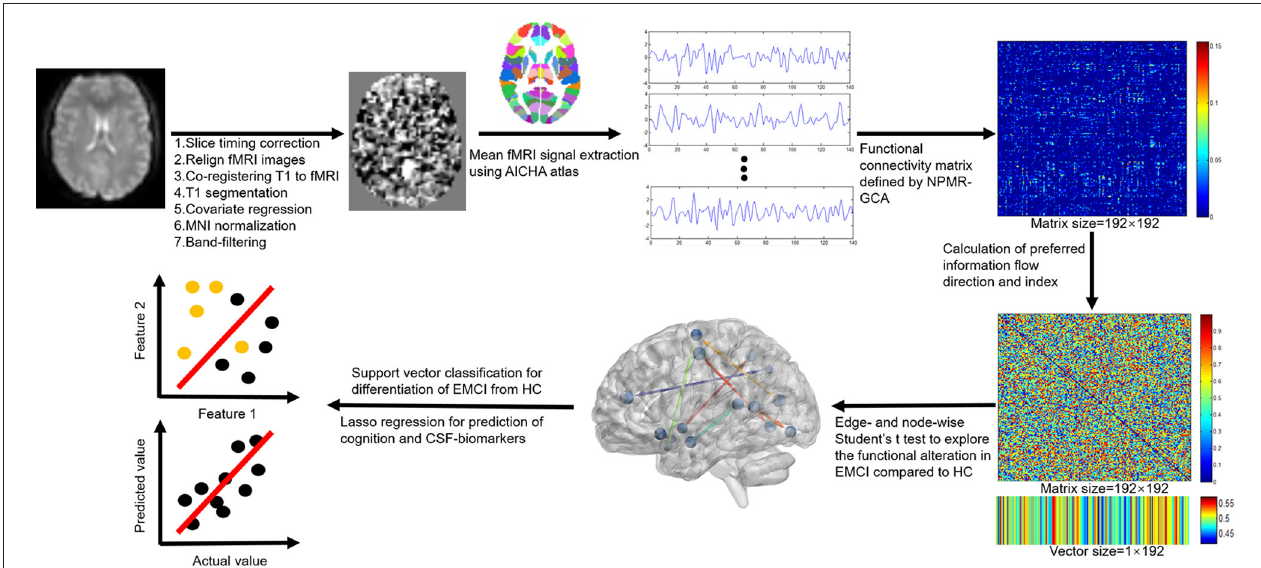
FIGURE 1 | Functional MRI (fMRI) processing and analysis flowchart of the study.